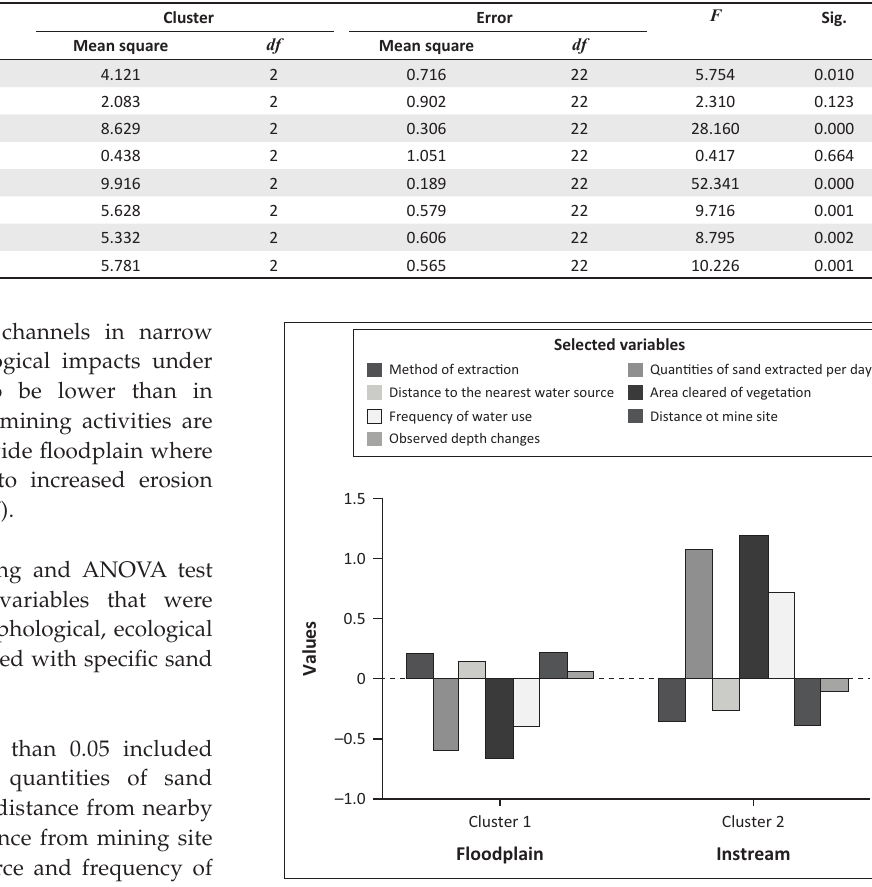
FIGURE 8: K -means clustering by type of sand mining